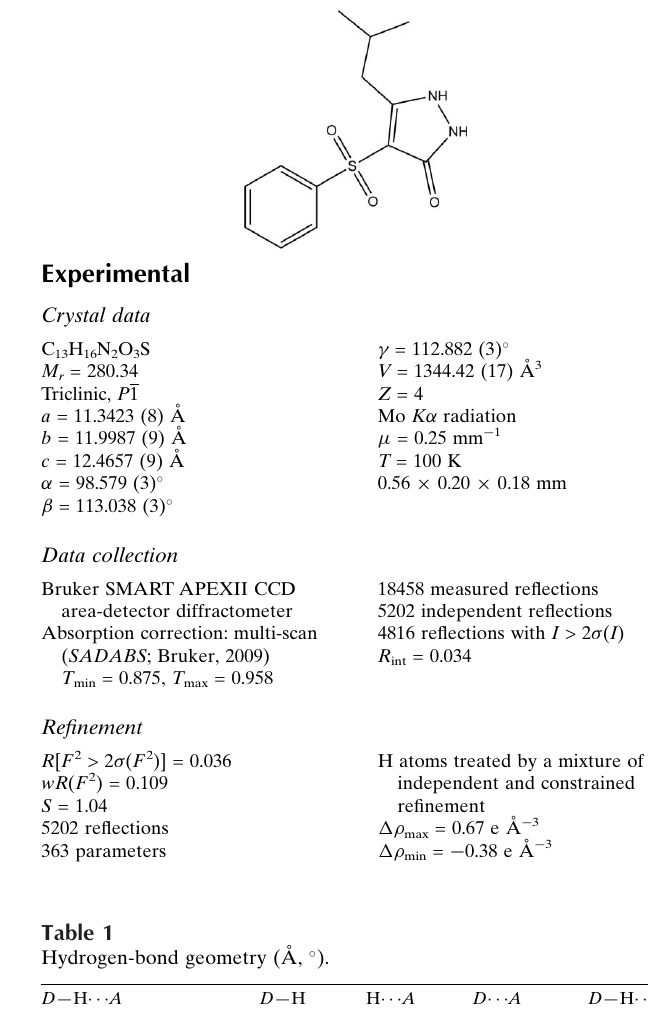
Hydrogen-bond geometry (A˚ , (cid:2) ). D —H (cid:3)(cid:3)(cid:3) A D